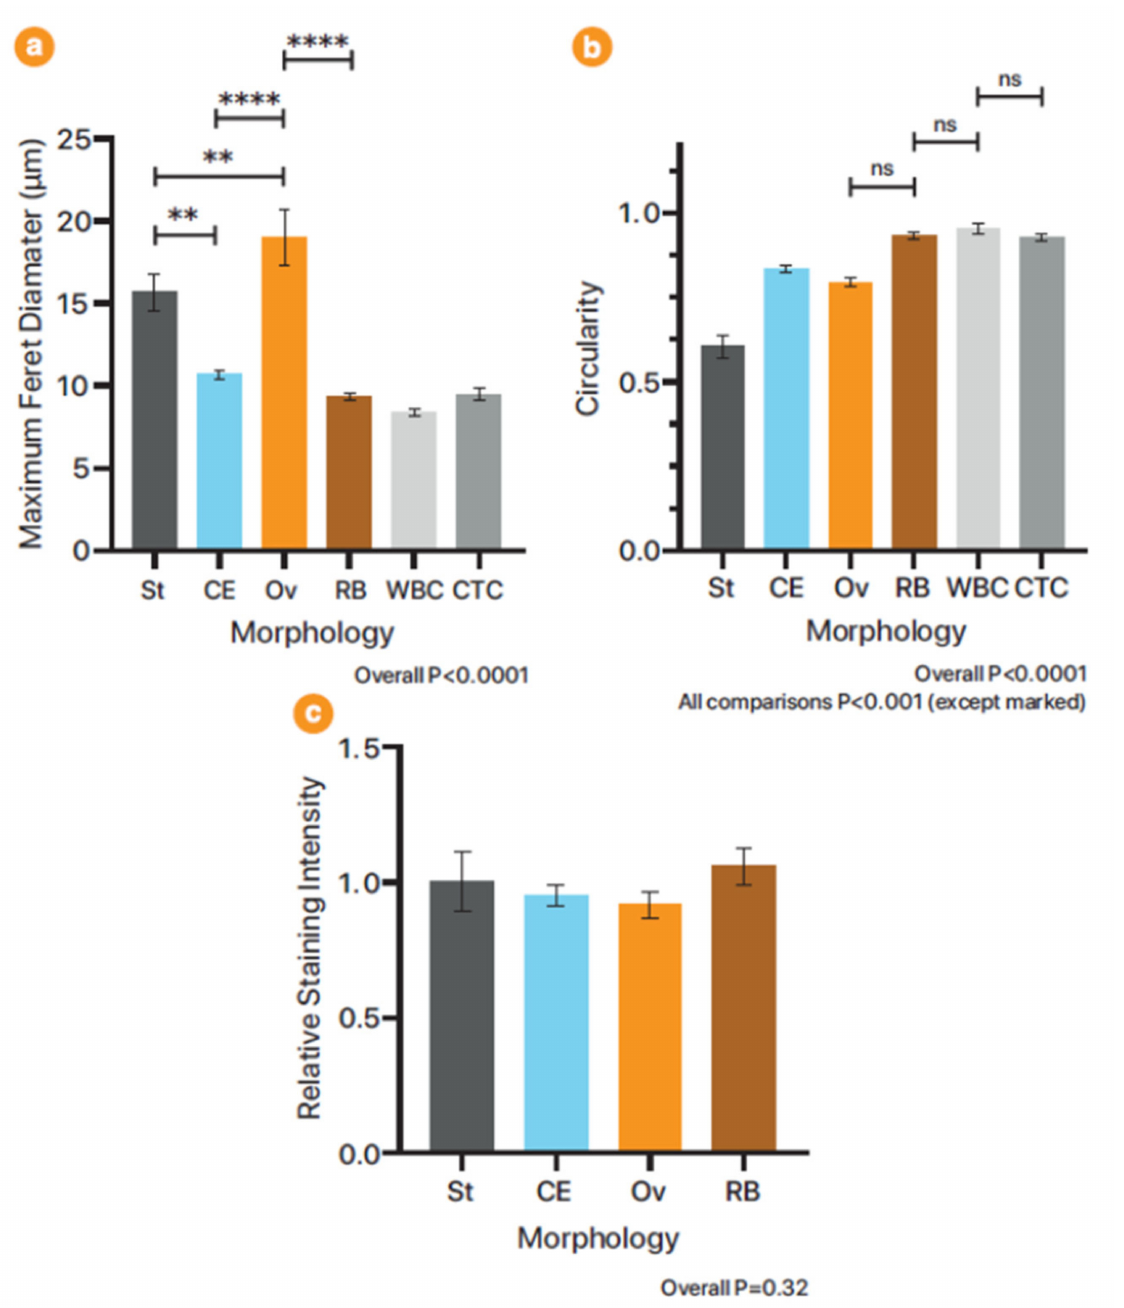
Figure A7. Selected measurements for cPSCs according to morphology type. ( a ) Maximum Feret diameter. This is the caliper diameter of the largest dimension of the cell. There was an overall significant difference ( p < 0.0001 on ANOVA). The significant differences between groups (by Tukey’s multiple comparison test) are highlighted by the capped lines. Leucocyte (WBC) and CTC diameters are shown for comparison. For clarity, p -Value for comparisons with these cells are not shown. ( b ) Circularity. This is calculated by the formula circularity = 4 π × (area / perimeter 2 ). A value of 1.0 represents a perfect circle. As the value tends towards zero, it represents an increasingly elongated polygon. All multiple comparisons were statistically significant ( p < 0.0001) except for the comparisons indicated. ( c ) Relative staining intensity for α -SMA. This represents the staining intensity for each cell in the α -SMA channel relative to the mean of all measurements. There were no significant differences between the groups. Abbreviations: WBC, white blood cell. Abbreviations for morphologies described in the text. ** p < 0.01, **** p <